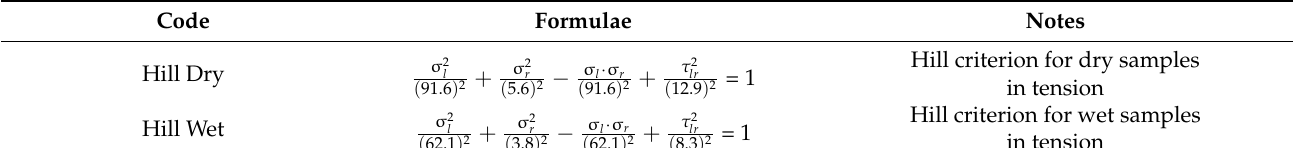
Table 4. Hill criteria showing in Figure 10 below.